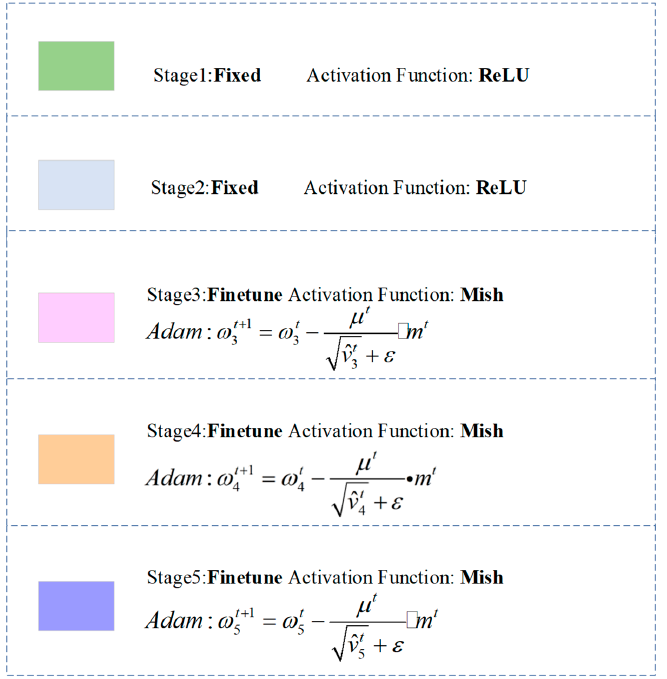
Figure 5. The architecture of the FT-ResNet50